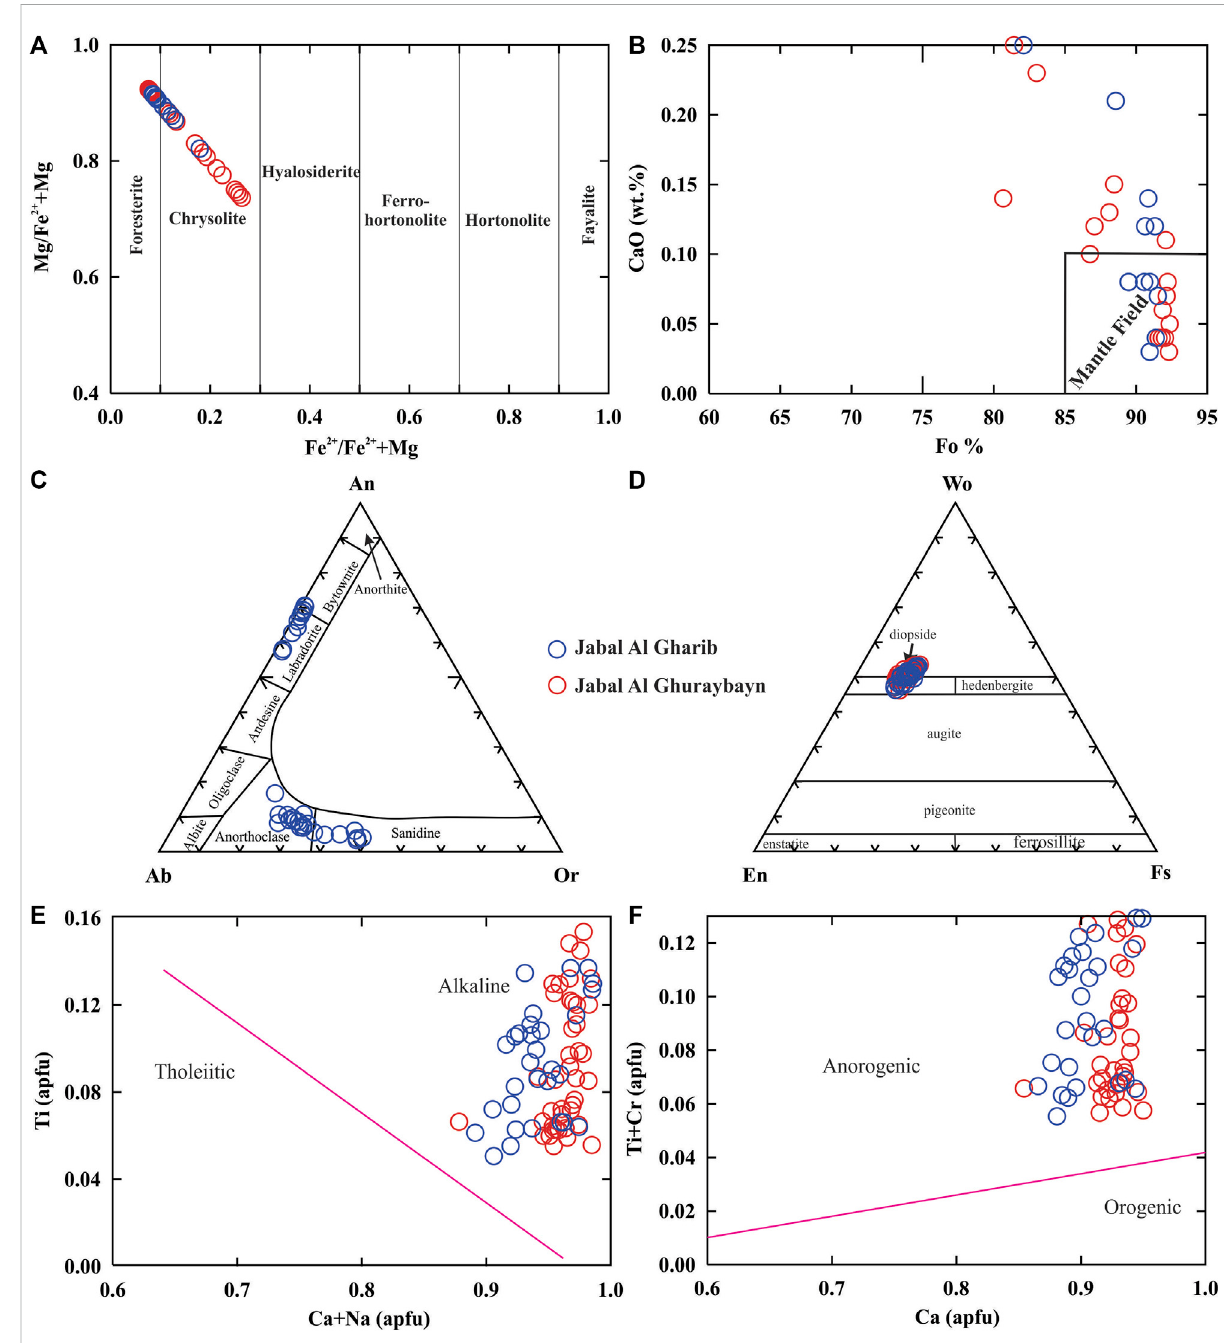
FIGURE 4 (A) Olivine classi fi cation diagram. (B) CaO vs. Fo% of olivine compositions. Mantle fi eld is after Thompson and Gibson (2000) and Kamenetsky et al. (2006). (C) Ab-An-Or classi fi cation diagram for feldspars (Deer et al., 1992). Pyroxene compositions are plotted on (D) En-Wo-Fs classi fi cation diagram (Morimoto et al., 1988), (E) Ca + Na vs. Ti diagram, and (F) Ca vs. Ti + Cr diagram (Leterrier et al.,